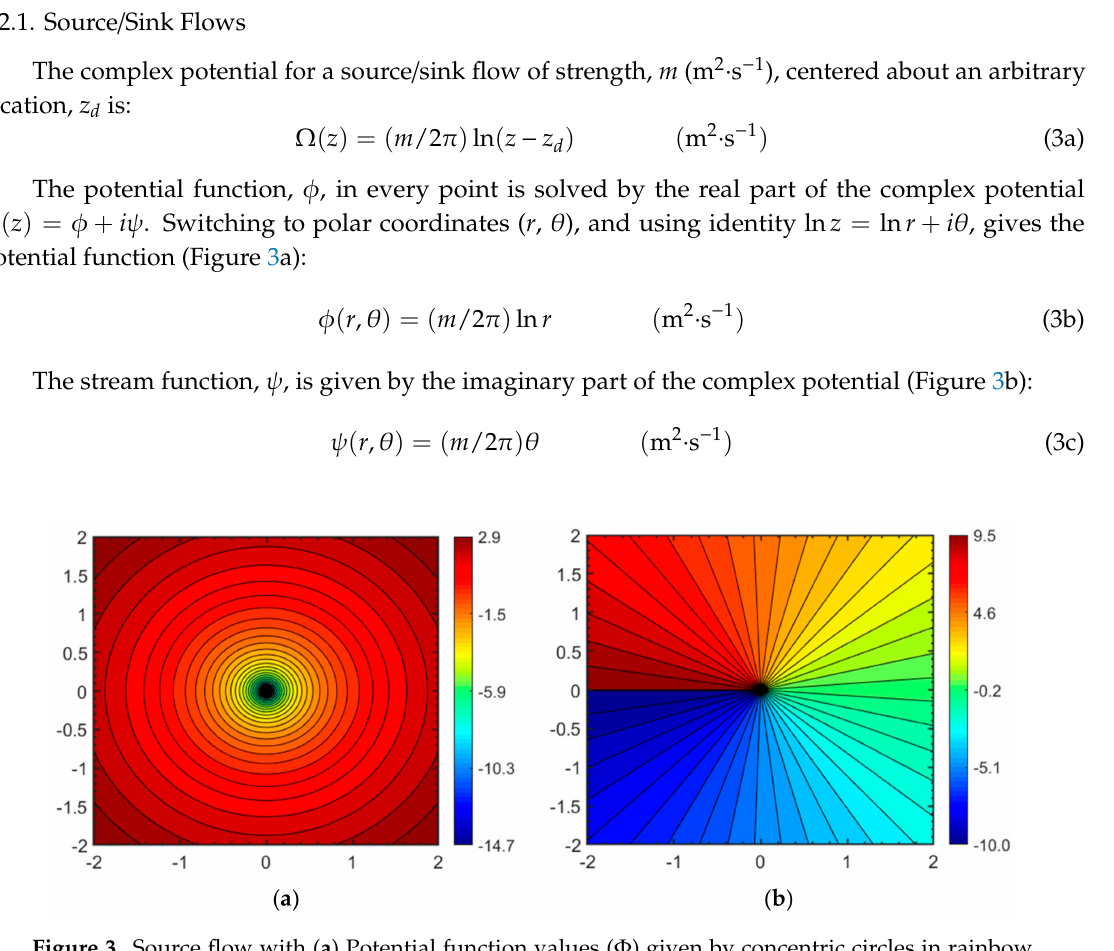
Figure 3. Source flow with ( a ) Potential function values ( Φ ) given by concentric circles in rainbow colors. ( b ) Stream function values ( Ψ ) given by straight radials in rainbow colors. Strength of source (m) = 20 m 2 · s − 1 and z d = 0. The potential function highs and lows slope opposite to the pressure